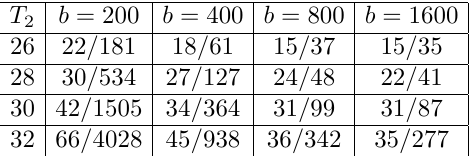
Table 9: Ratio between the number of parity patterns that give rise to trails with weight below T 2 and the number of parity patterns with bound below T 2 , according to